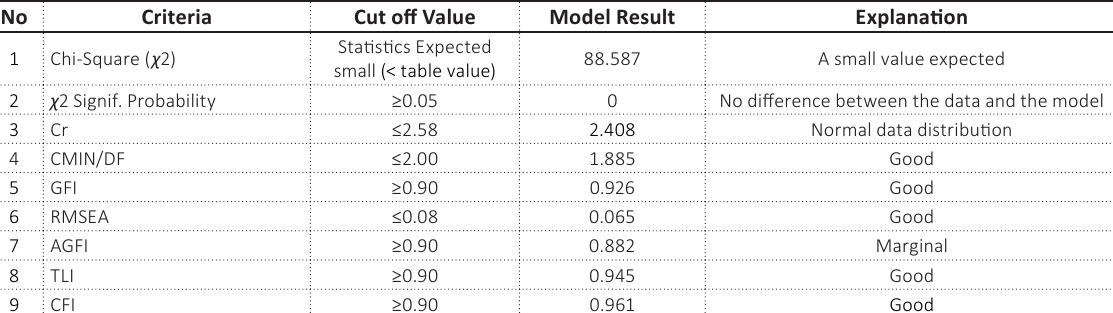
Table 7. Model feasibility test